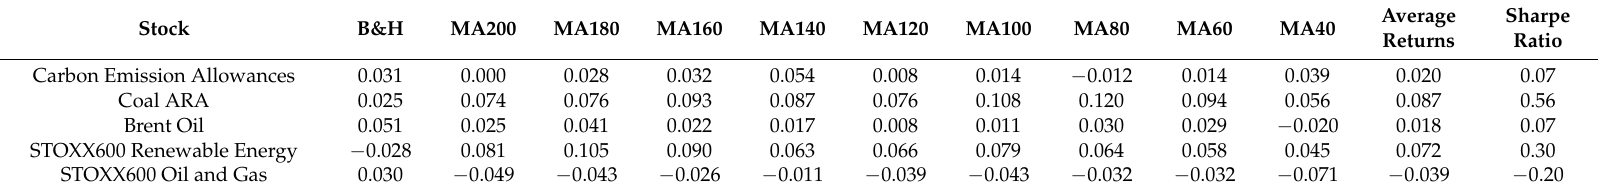
Table A1. Annualized daily returns of MA40–MA200, average returns and Sharpe ratios.